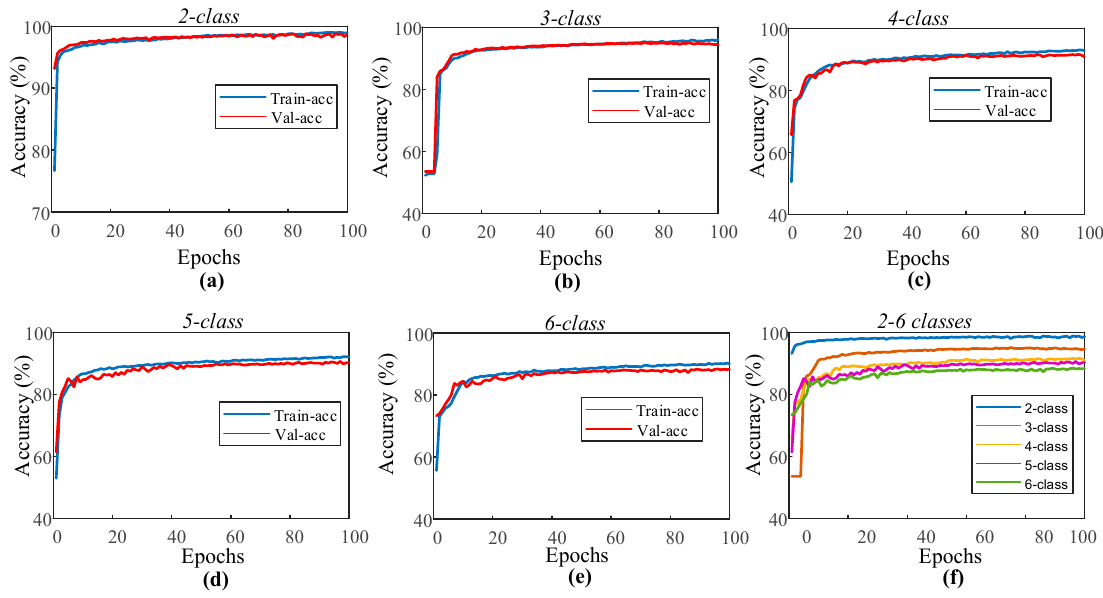
Figure 6. Performance graphs of the proposed 1D-CNN model with the single channel EOG signal for the sleep-edf dataset: ( a ) two-class model, ( b ) three-class model, ( c ) four-class model, ( d ) five-class